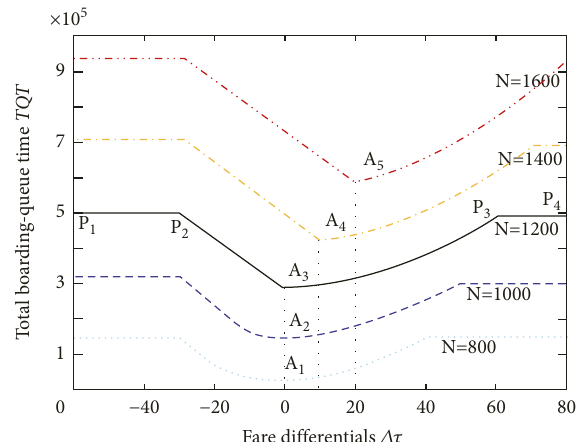
Figure 6: Effect of fare differentials on boarding congestion.